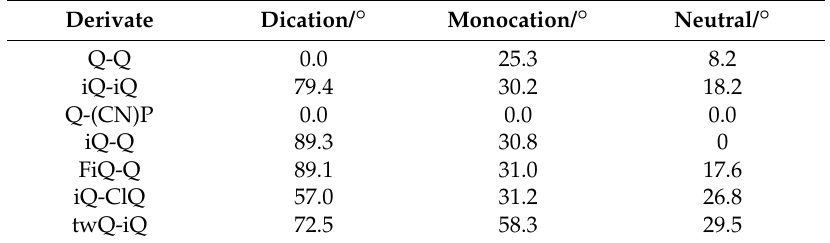
Table 2. Dihedral angles between rings obtained from calculations. The data were obtained at the B3LYP/6-31G(d) level of the theory.